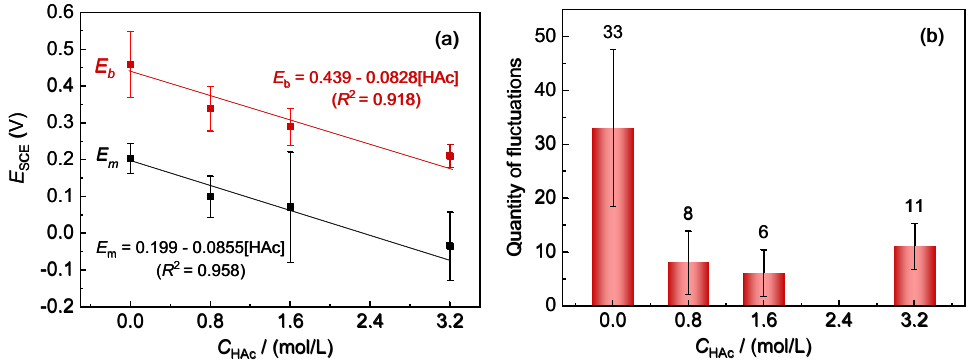
Figure 2. Variation of E m and E b of 304 SS with different HAc concentrations, in 0.6 mol/L NaCl solution ( a ) and a bar graph of the number of current fluctuations of 304 SS in 0.6 mol/L NaCl solutions with HAc ( b ).